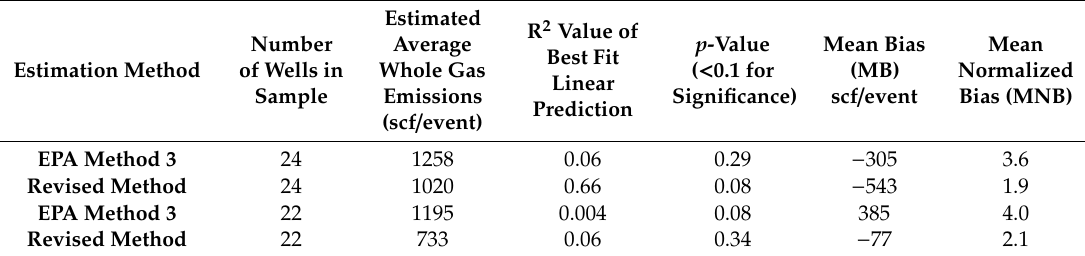
Figure 1. Linear best fit comparisons between measured emissions per event from the Allen et al. [11] field study and two engineering estimation methods: the current EPA Method 3 and the revised method proposed in this study. Comparisons are made for 24 wells in the Allen et al. [11] data set ( a ) and for 22 non-outlier wells ( b ). Table 1. Statistical measurements of model performance for average whole gas emissions in standard cubic feet (scf) per event compared to field measurements from Allen et al. [11]. For comparison, the average measured emission rates per event for the 24 well sample was 1563 scf per event. Analysis with 22 wells eliminated two outlier points with averaged measured emission rates above 8000 scf per event, and this subset of wells had average whole gas emission rates of 810 scf per event.